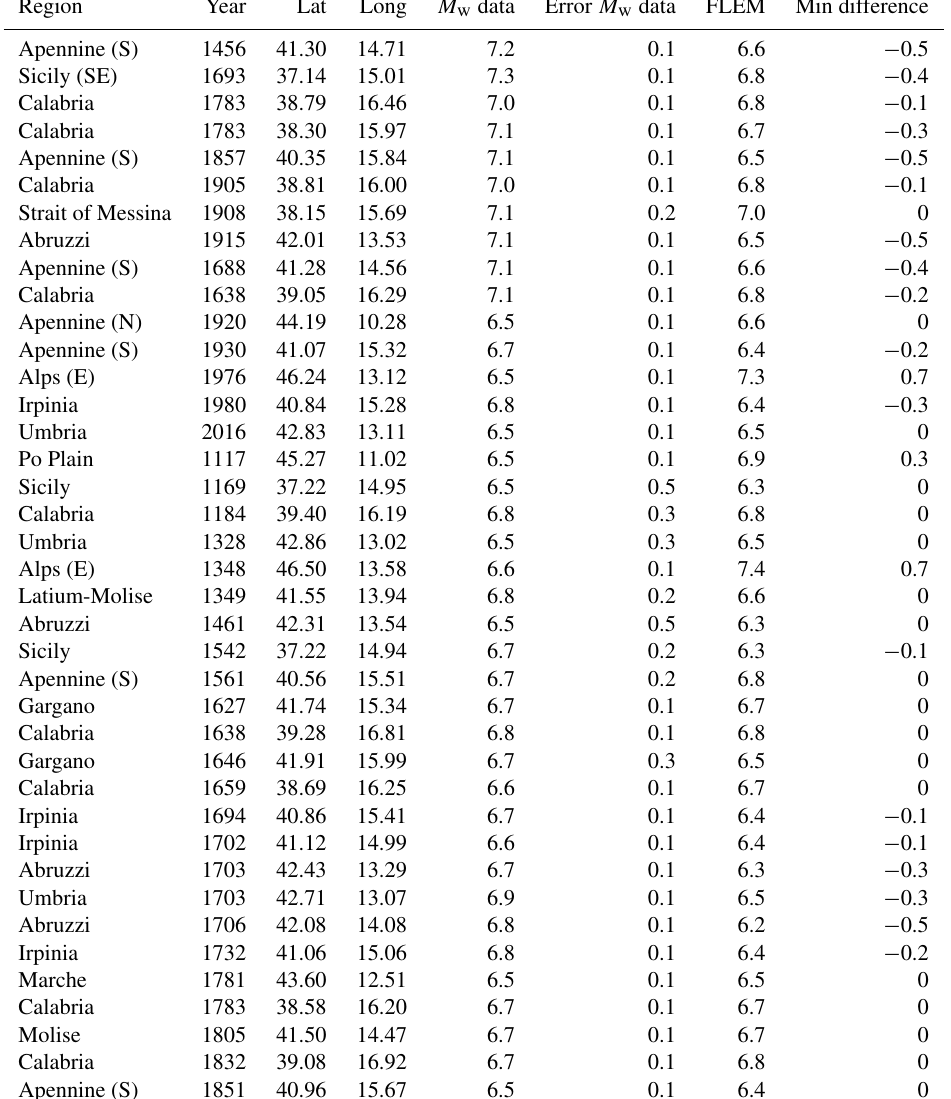
Table 1. Catalogued historical and instrumental earthquakes ( M w ≥ 6 . 5, 1000–2017 period) plotted in Fig. 13 with spatially coincident (same 25km × 25km cell) FLEM. Catalogued data are from Castello et al. (2006), Iside Working Group (2016), and Rovida et al.